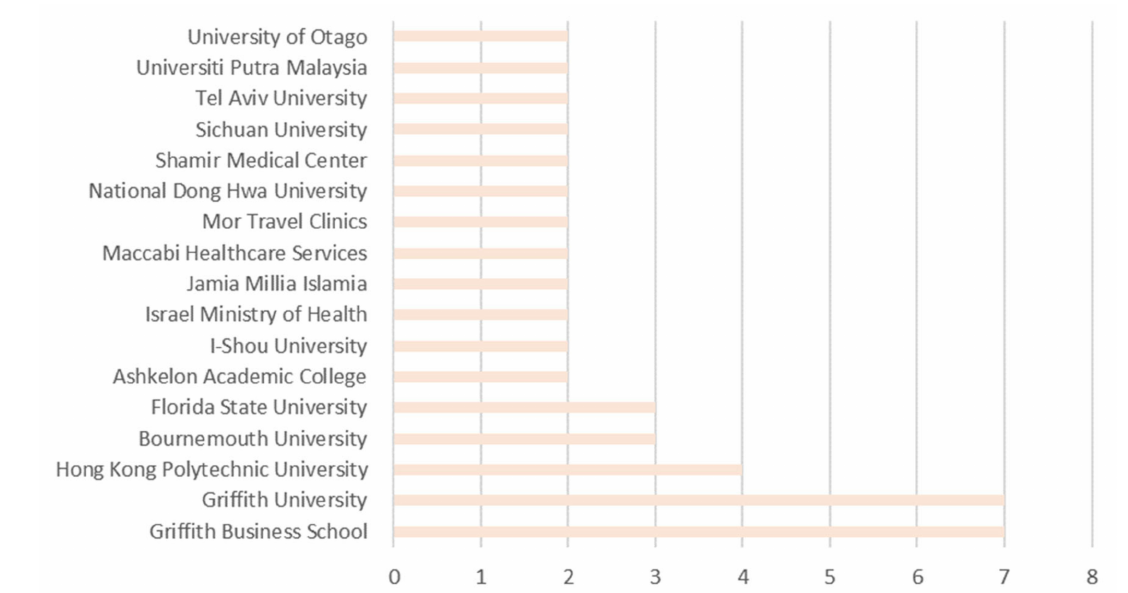
Figure 5. Top universities contributing to the subject of “Solo Travel” (at least two articles published).